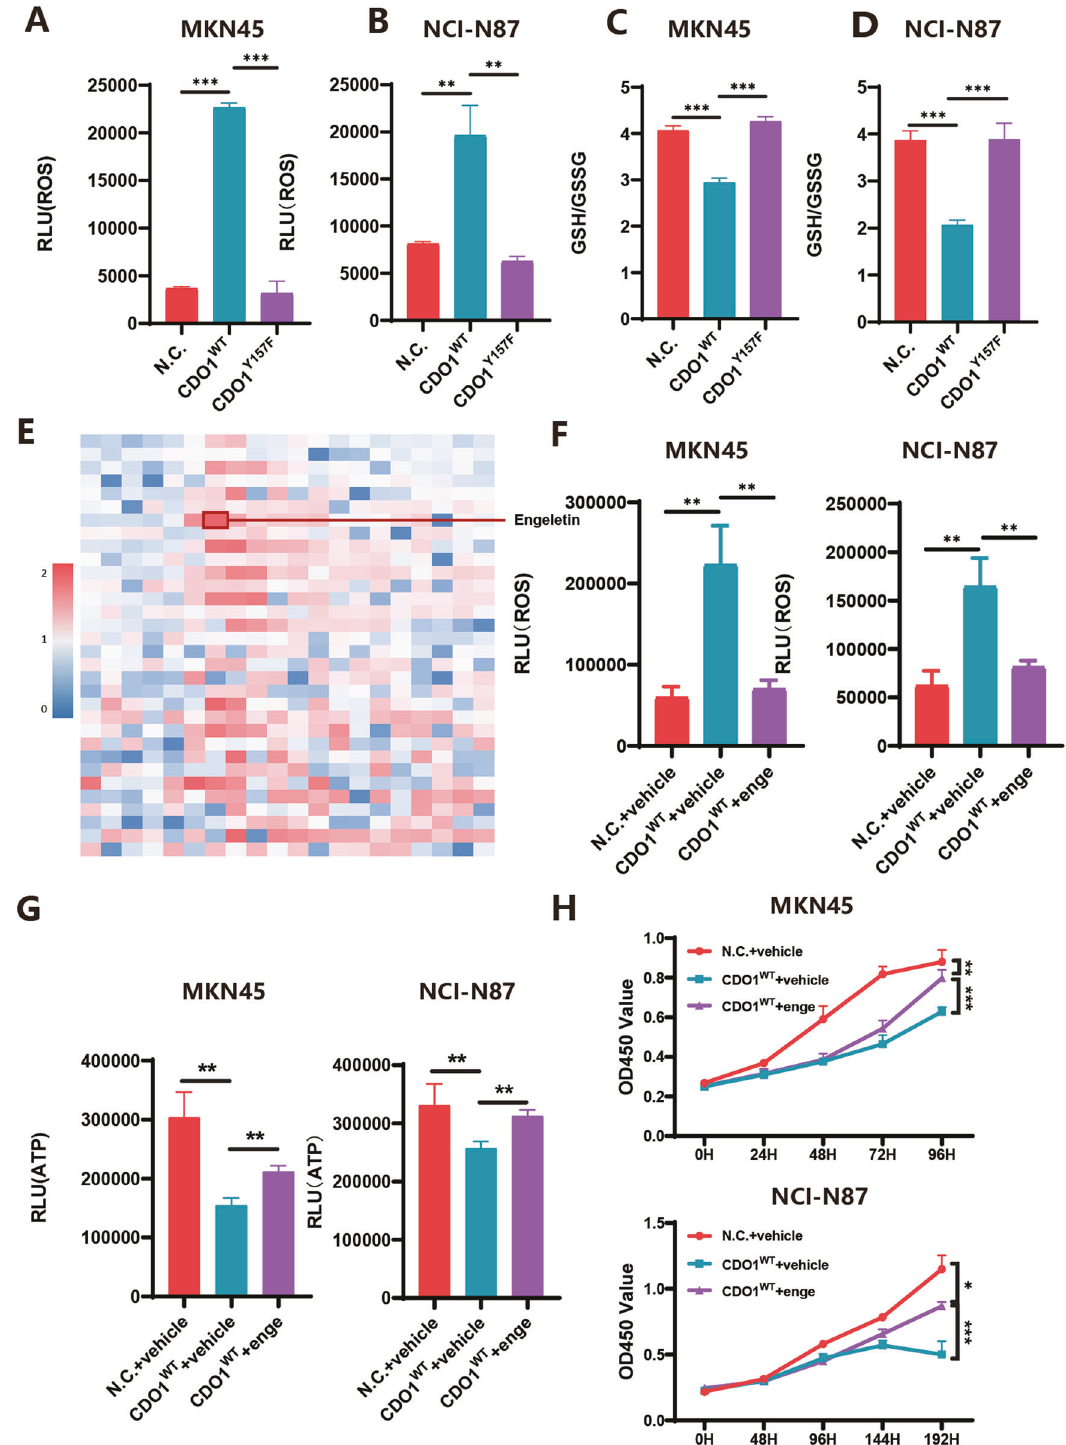
Fig. 4 CDO1 induces oxidative stress in GC cells. A , B CDO1 WT markedly increased ROS level while CDO1 Y157F did not alter ROS production in MKN45 ( A ) and NCI-N87 (B) cells. C , D CDO1 WT rather than CDO1 Y157F decreased GSH/GSSG ratio in MKN45 ( C ) and NCI-N87 ( D ) cells. E Heatmap of the fold changes in all antioxidants subjected to HTS relative to MKN45 cells treated with DMSO (Vehicle). Intracellular ATP level, measured using CellTiter-Glo, was used as the surrogate of viable cells. Luminescent reads of engeletin-treated MKN45 cells approximately increased by two times. The fold changes were measured as: Fold change = (Reads (antioxidant) -Reads (Vehicle) ) / Reads (Vehicle) . F Engeletin- treated MKN45 (left panel) or NCI-N87 (right panel) cells with CDO1 WT restoration displayed reduced ROS production compared to these cells exposed to vehicle. G Treatment of Engeletin in MKN45 (left panel) or NCI-N87 (right panel) cells with restored CDO1 WT increased ATP generation relative to vehicle-treated cells. H CCK-8 assays demonstrated that engeletin treatment relieved the inhibition of CDO1 WT on the proliferation in MKN45 (upper panel) or NCI-N87 (bottom panel) cells in vitro. * p < 0.05, ** p < 0.01, *** p < 0.001.